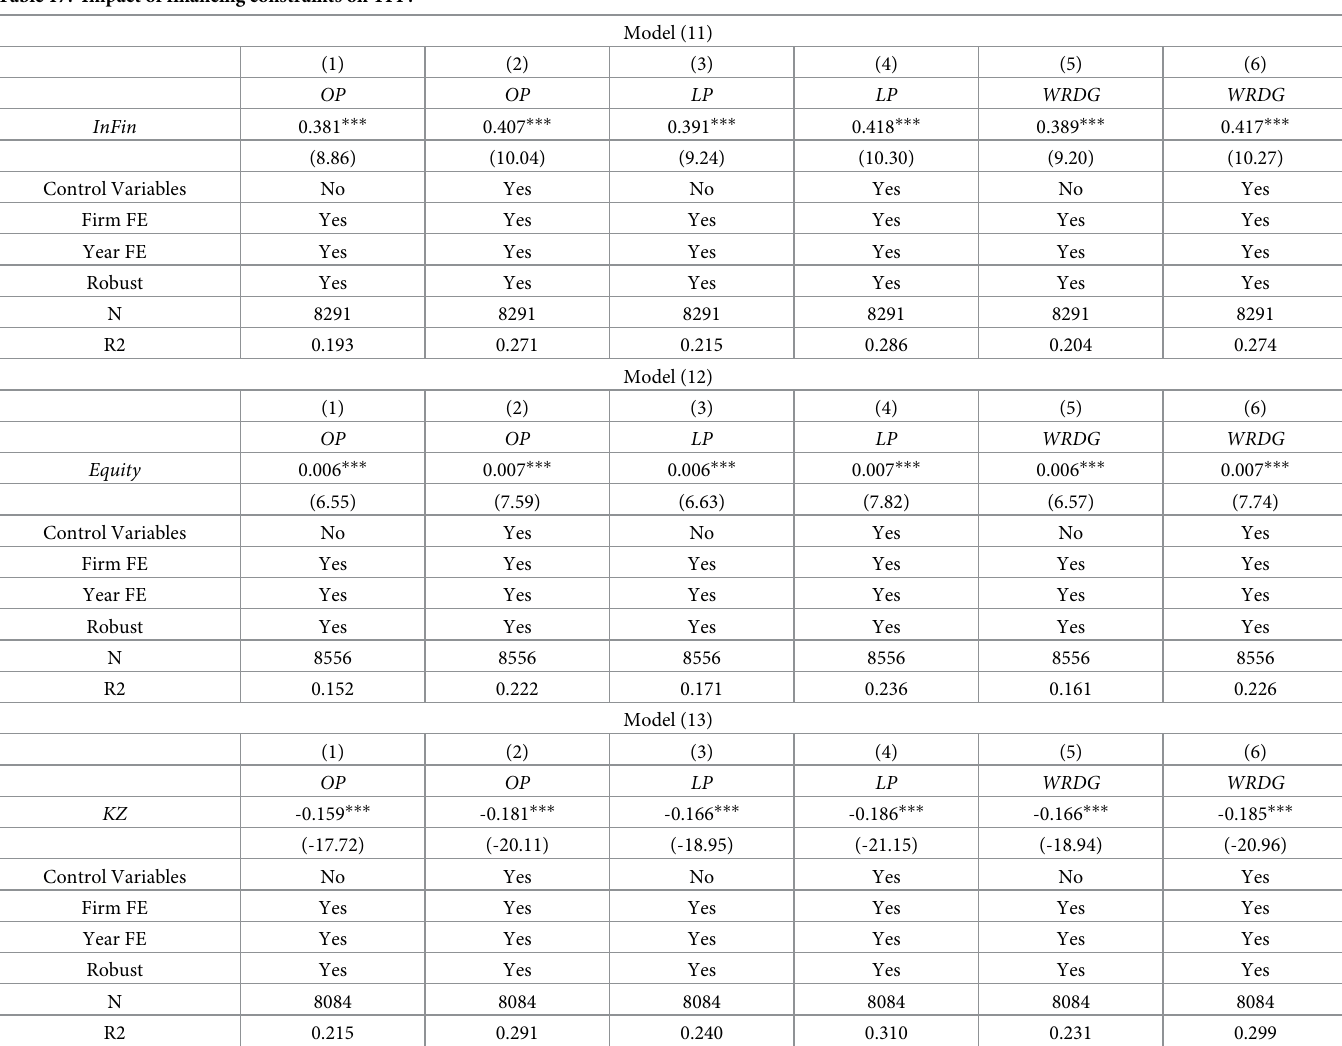
Table 17. Impact of financing constraints on